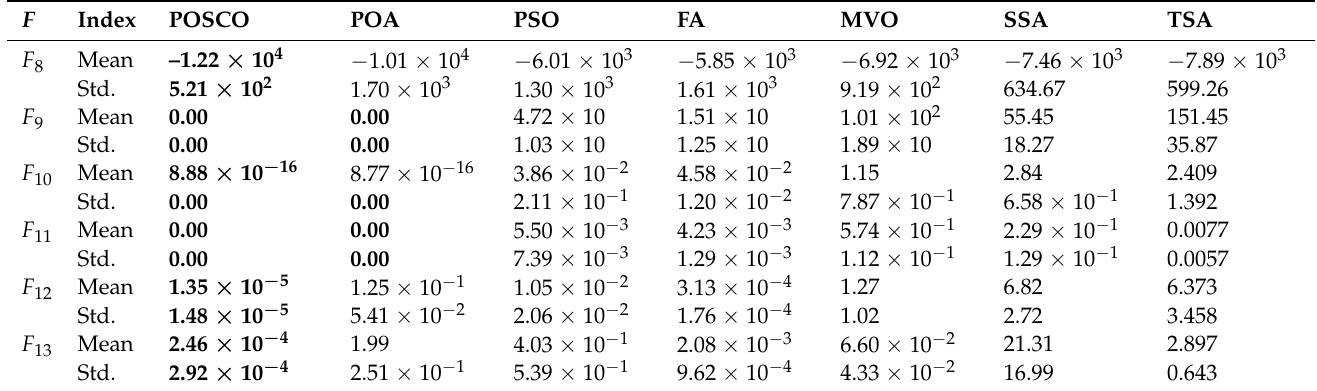
Table 6. Results of multimodal test functions